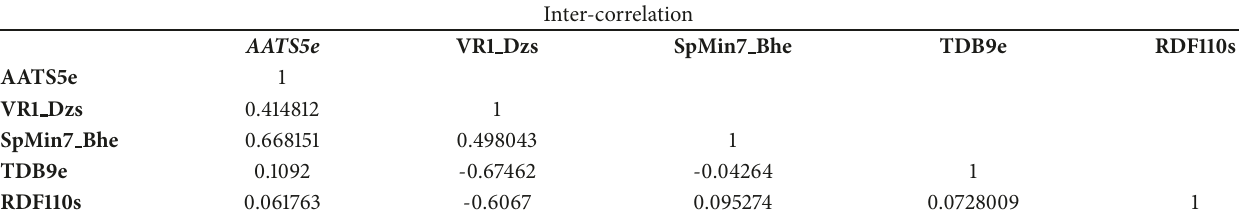
Table 5: Pearson’s correlation coefficient for the descriptor used in the QSAR